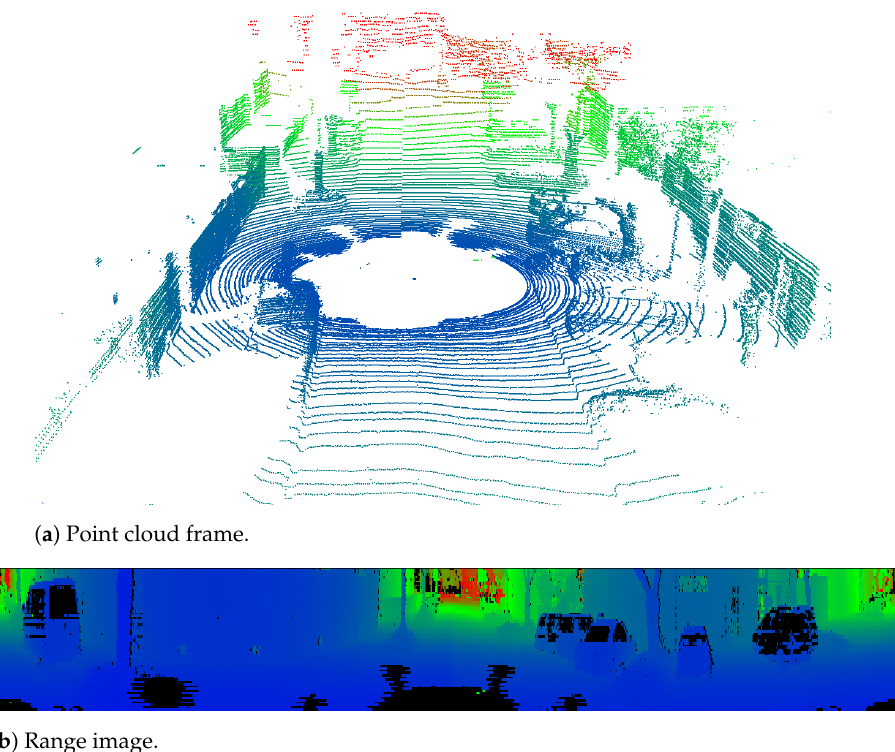
Figure 14. Conversion of a point cloud frame to a range image